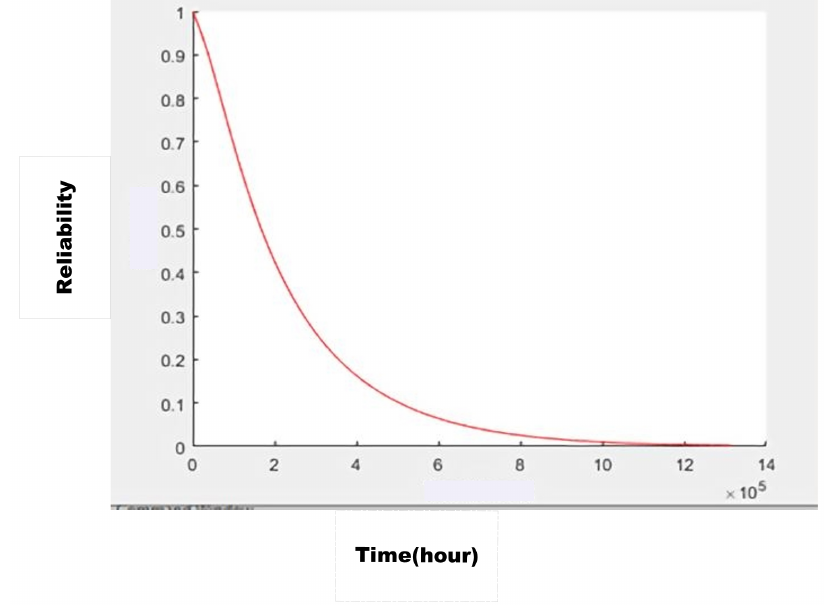
Figure 5. Bridge-linked PV panel